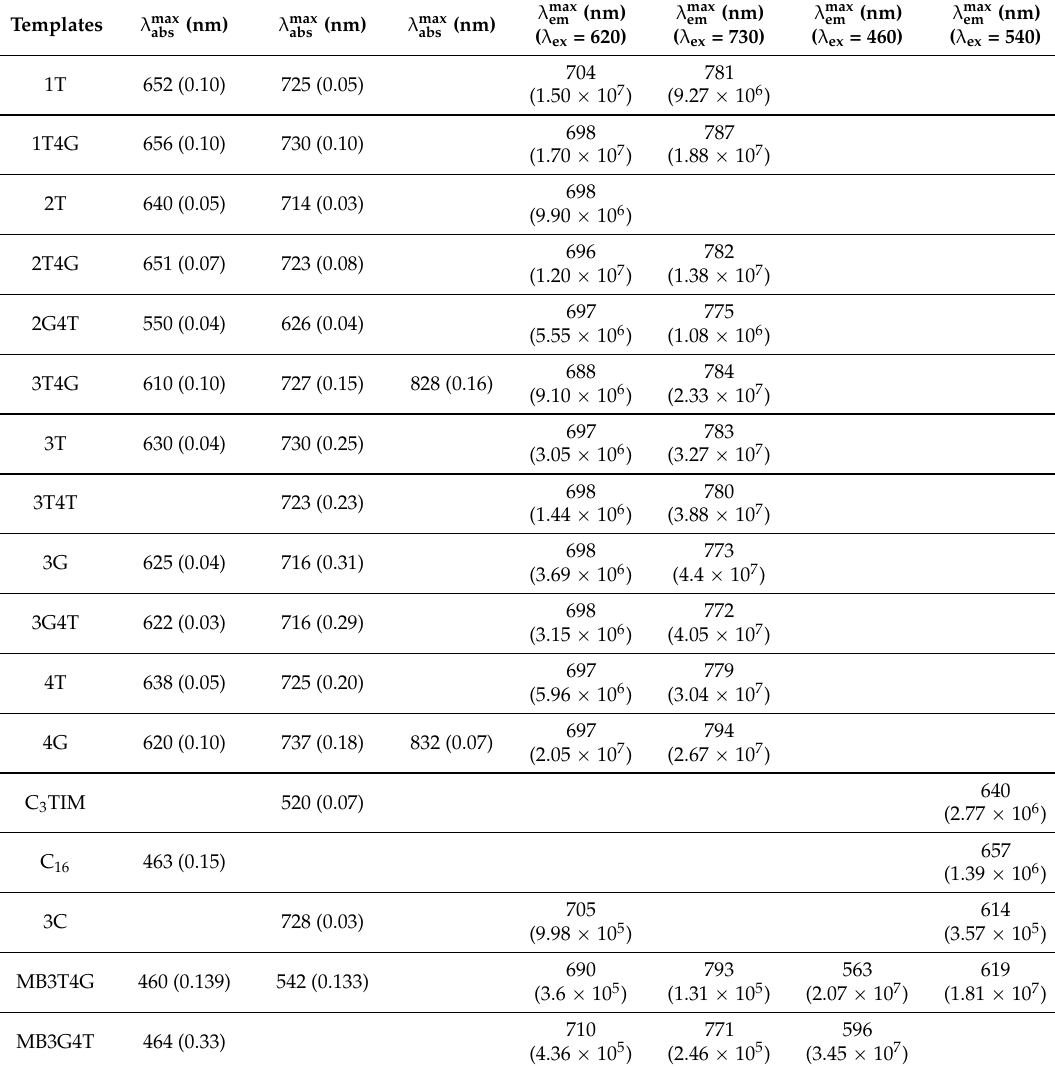
Table 1. Absorption maxima ( λ max ) along with absorbance (a.u) and fluorescence emission maxima abs ( λ max em , corrected) along with the intensities (cps) of the silver nanocluster species formed on the 15 µ M single stranded DNA templates ([DNA]:[Ag] = 1:6) with the repeated base sequence 5 1 -C 3 X i C 3 X ii C 3 X iii C 3 X iv -3 1 where i, ii, iii, iv correspond to T/G/C deoxynucleobases (with